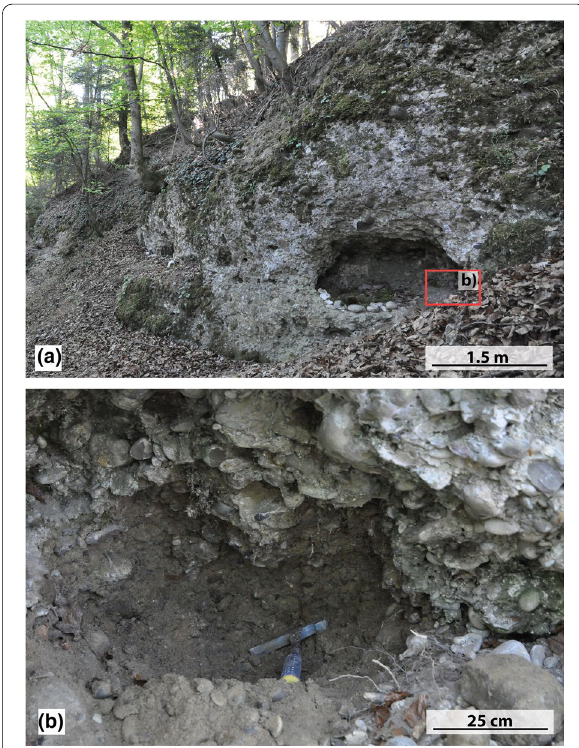
Fig. 7 Field photographs from the Chroobach site. a Overview of the well-cemented gravel outcrop along the hiking path and position of photograph b . b Close-up photograph indicating the uncemented poorly-sorted